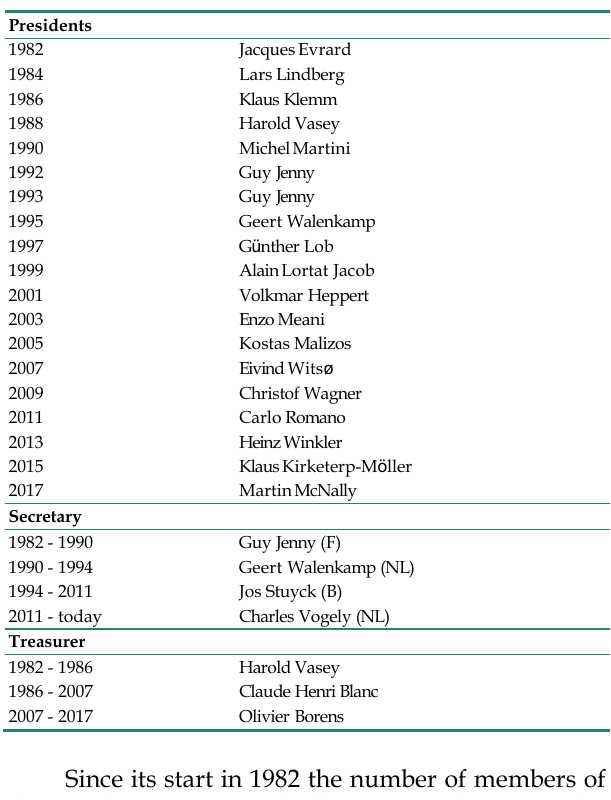
Table 2. Presidents, Secretaries, and Treasurers of the Study Group and Society. Jenny was President of the Studygroup (1992) and subsequently also of the Society (1993).